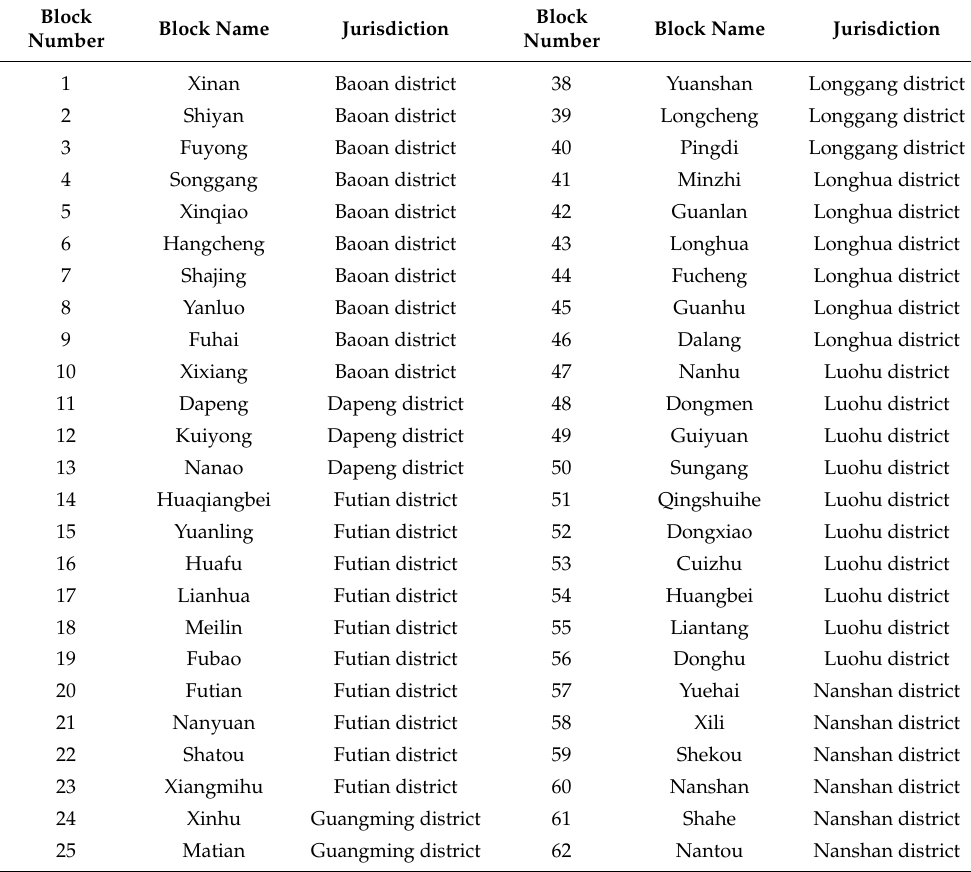
Table 2. Block names and administrative numbers in